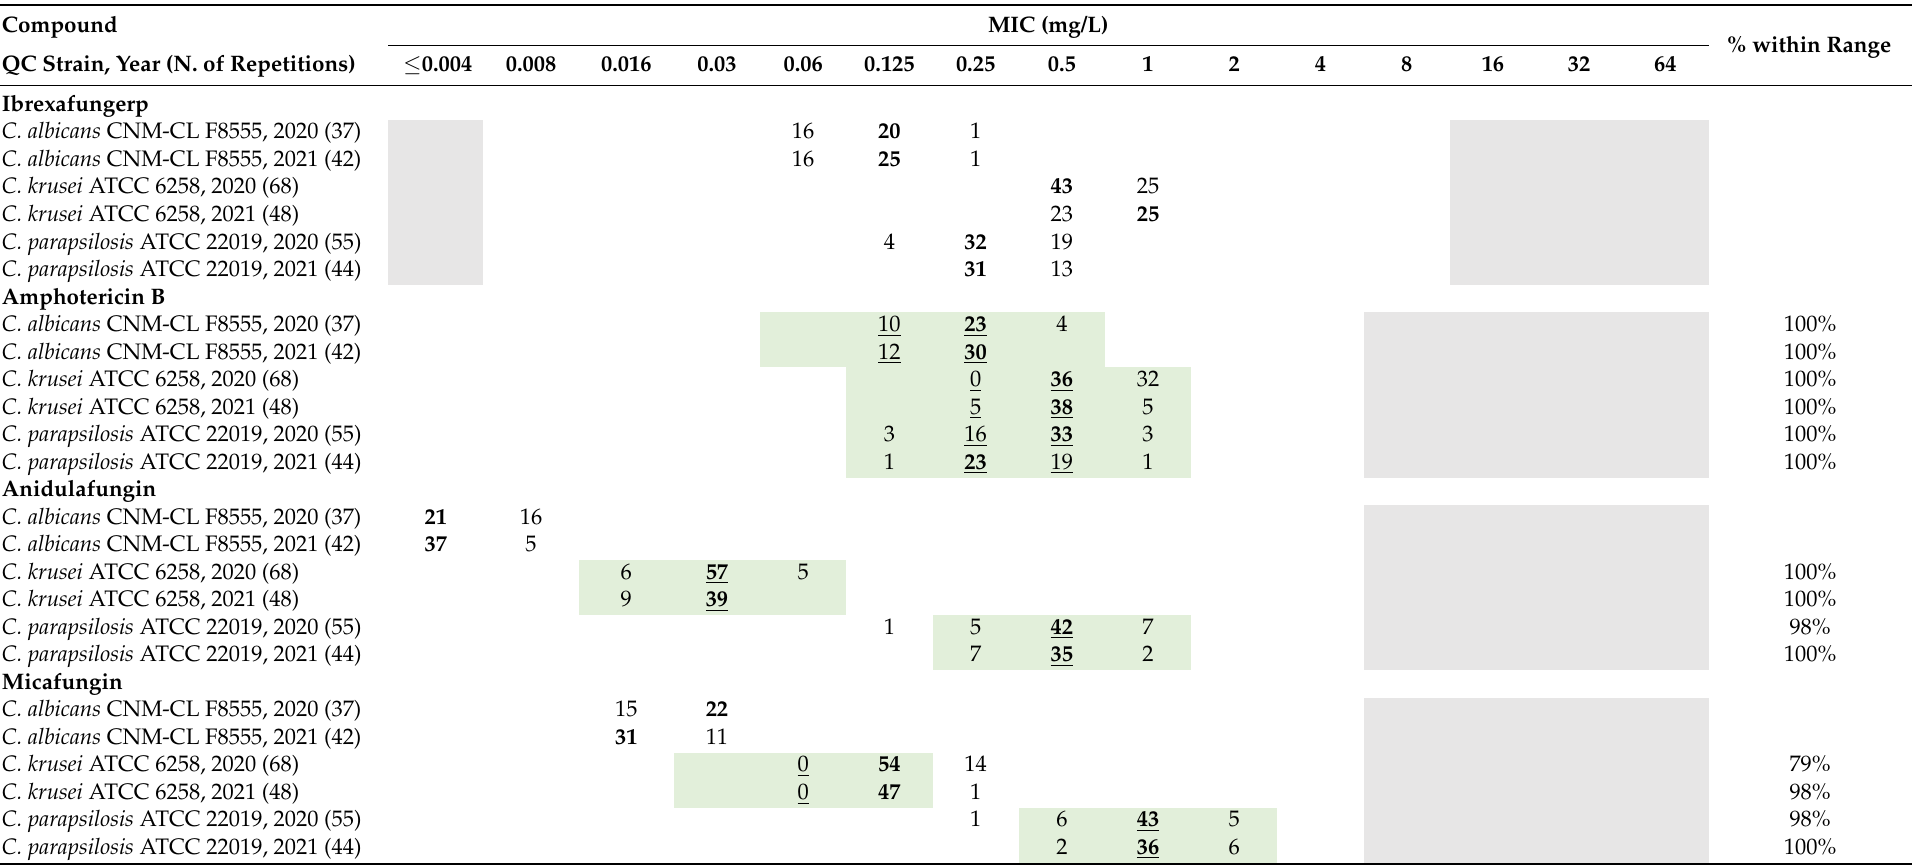
Table 2. MIC values for ibrexafungerp and comparators against three QC strains that were tested repetitively throughout the 2-year study period in parallel with the clinical